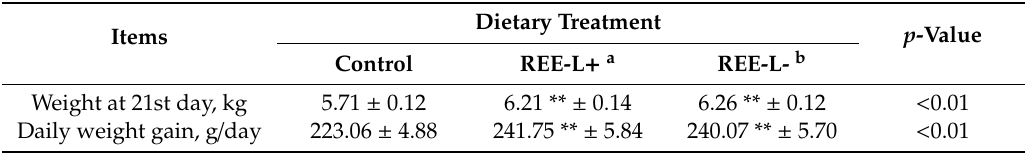
Table 3. E ff ects of REE supplementation during the late gestation and lactation on growth performances of the piglets.